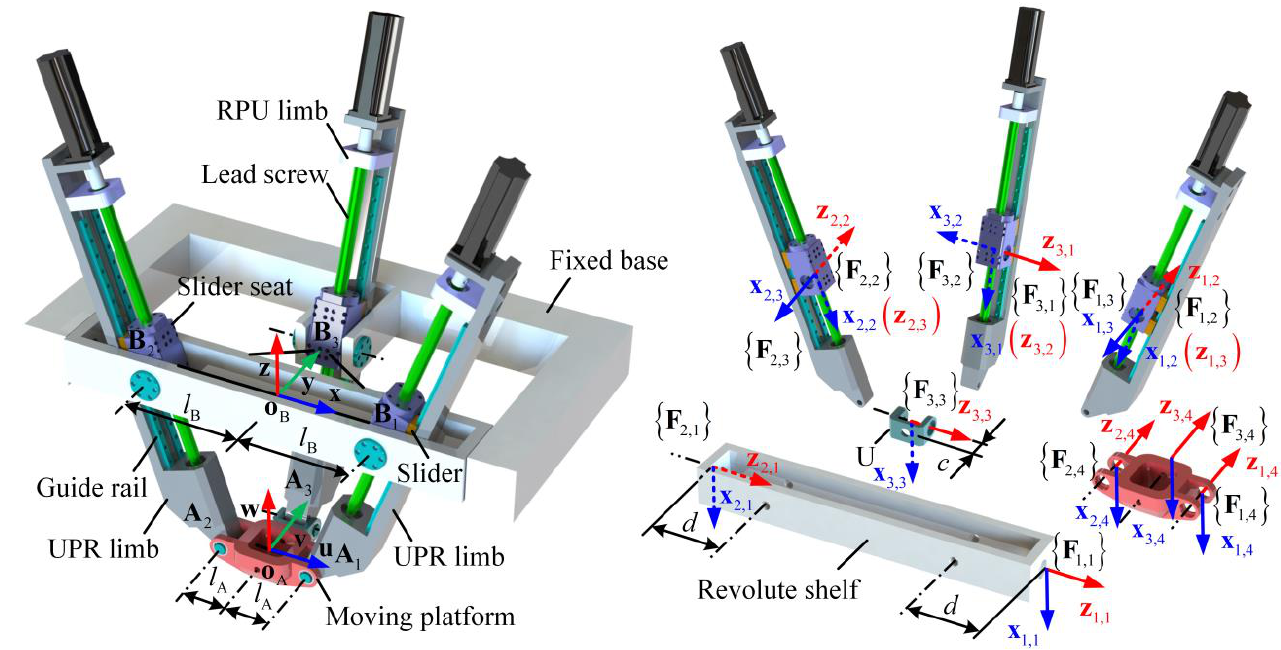
Figure 2. 2UPR-RPU parallel manipulator and its local coordinate systems.